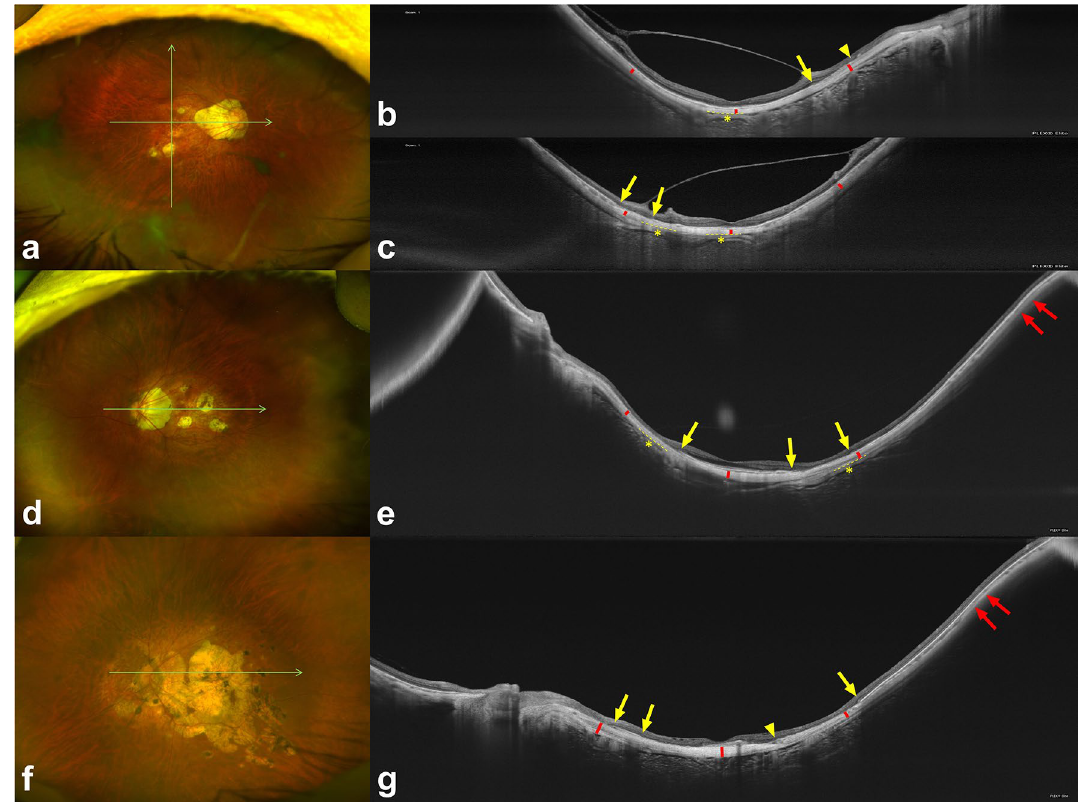
Figure 3. Images of highly myopic eyes with myopic maculopathy of category 3 (patchy chorioretinal atrophy) or 4 (macular atrophy). The green arrows represent the cross-section through which optical coherence tomography (OCT) scan was performed, and red bars represent scleral thicknesses at the fovea and 3 mm from the fovea. In some images, the episcleral tissue appears as a uniform structure outside of the sclera with a slightly lower reflectivity (asterisks). Interfaces between the sclera and episcleral tissue are outlined with dashed lines. All OCT images were shown on a 1:1 µm scale. ( a – c ) A 74-year-old man with patchy chorioretinal atrophy. The axial length was 33.92 mm and best-corrected visual acuity (BCVA) was 20/63. The choroidal and scleral thicknesses at the foveal, superior, inferior, temporal, and nasal regions were 15, 25, 34, 21, 0 µm and 108, 126, 101, 104, 168 µm, respectively. Note the margin of retinal pigment epithelium defects (arrows) and end of Bruch membrane (arrowhead). ( d , e ) A 71-year-old woman with patchy chorioretinal atrophy. Axial length was 32.42 mm and BCVA was 20/40. Choroidal and scleral thicknesses at the foveal, temporal, and nasal regions were 30, 15, 0 µm and 160, 156, 126 µm, respectively. Gradual thinning of the choroid is observed at the edge of the staphyloma (red arrows). Note the margin of retinal pigment epithelium defects (yellow arrows). ( f , g ) A 59-year-old man with choroidal neovascularization-related macular maculopathy. Axial length was 29.53 mm and visual acuity was count finger. On OCT, subretinal hyperreflective lesions at the fovea and extensive loss of the choroid and retinal pigment epithelium-Bruch membrane complex within an area of macular atrophy are observed. Note the margin of retinal pigment epithelium defects (yellow arrows) and crumpled remnants of the Bruch membrane (arrowhead). Gradual thinning of the choroid is observed at the edge of the staphyloma (red arrows). Choroidal and scleral thicknesses at the foveal, temporal, and nasal regions were 0, 0, 0 µm and 217, 145, 226 µm,